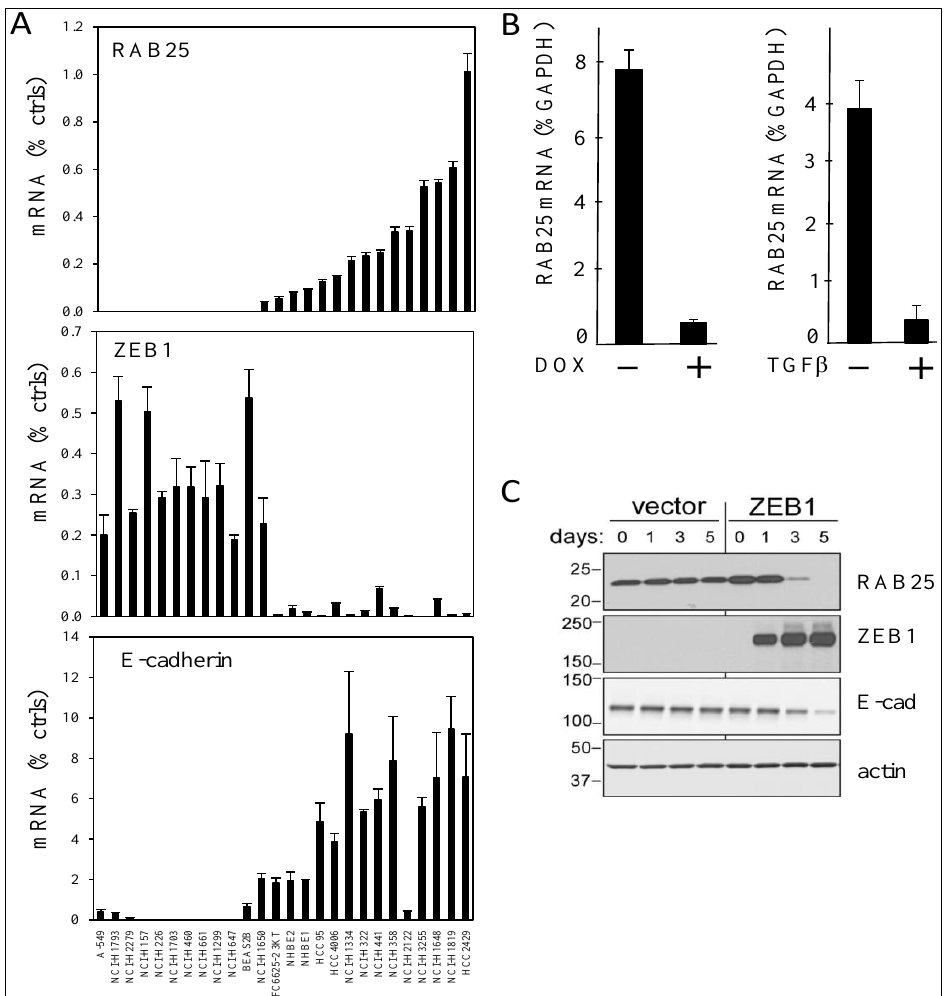
Figure 1. RAB25 is a ZEB1 target gene. ( A ) RAB25 expression positively correlated with E-cadherin but negatively with ZEB1 in a series of lung cancer cell lines. RNA expression was measured by quantitative real-time PCR in 22 NSCLC cell lines, two NHBE cultures, and two immortalized human airway primary cell lines (BAES2B and FC6625-2 3KT). Cells are ranked from left to right with increasing RAB25 mRNA level. Values are expressed as percent of the geometric mean between GAPDH and actin mRNA. The experiment was done twice with qRT-PCR in duplicate. ( B ) RAB25 mRNA level is decreased by ZEB1 overexpression in H358 FlipIn ZEB1 cells (left) and by TGFβ treatment in H358 EV control cells (right). Values are expressed as percent of GAPDH for three independent experiments with qRT-PCR in duplicate. Bars = SD. ( C ) Western blot: RAB25 protein level is decreased by ZEB1 overexpression during 1 to 5 days of DOX treatment in H358 FlipIn ZEB1cells. E-cadherin is decreased as well. Actin is the loading control. Protein molecular weights are indicated in kDa on the